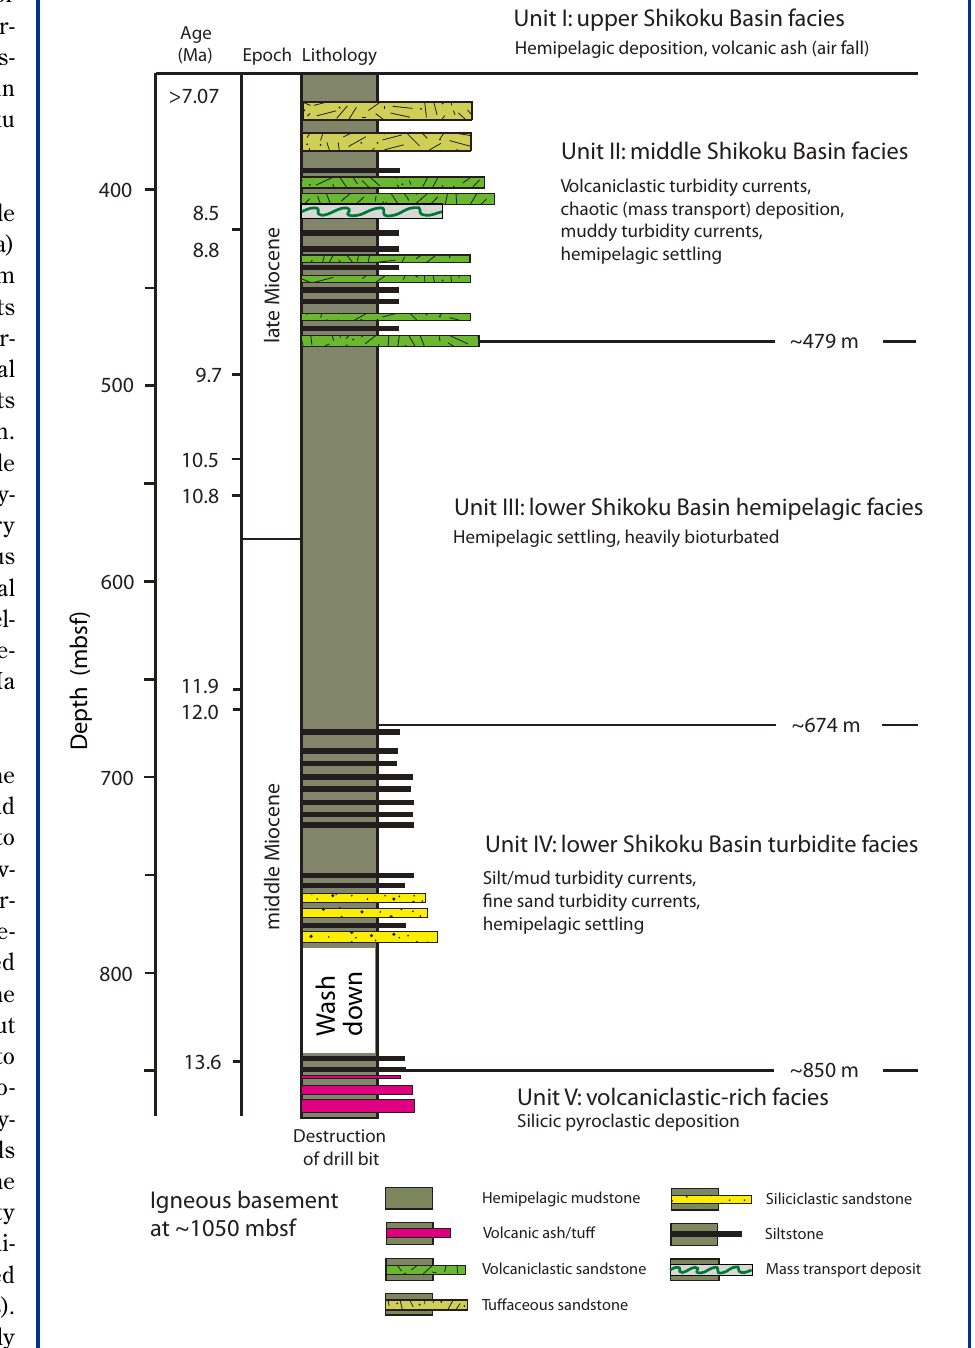
Figure 3. Lithologic units and depositional ages from nannofossils data Hole